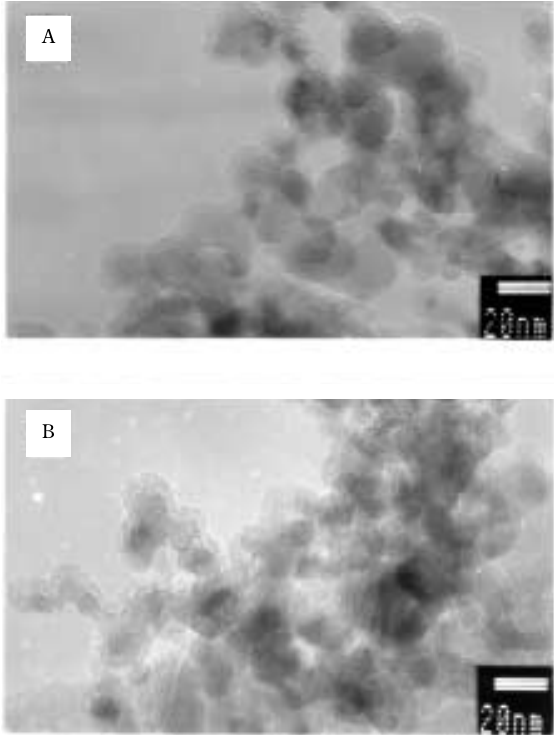
X-ray diffraction patterns for original and modified alu- mina. The number is the number of repetitions.